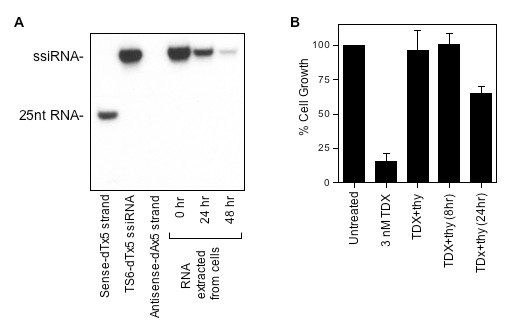
siRNA northern blot analysis. (a) TS6-dTx5 ssiRNA was transfected into RKO cells. After 6 h, the cell culture medium was replaced. RNA was extracted using Trizol immediately and after an additional 24 and 48 h followed by northern blot analysis as described in the Methods section. (b) Thymidine rescue of ZD1694 toxicity. RKO cells were incubated with 3 nM ZD1694 in the presence or absence of 10 uM thymidine. Thymidine (10 μM) was also added 8 and 24 h after ZD1694 addition. After an additional 72 h, cell proliferation was quantified by the WST-1 assay. Cell growth values represent the mean ± standard deviation (SD) from three experiments performed in duplicate.